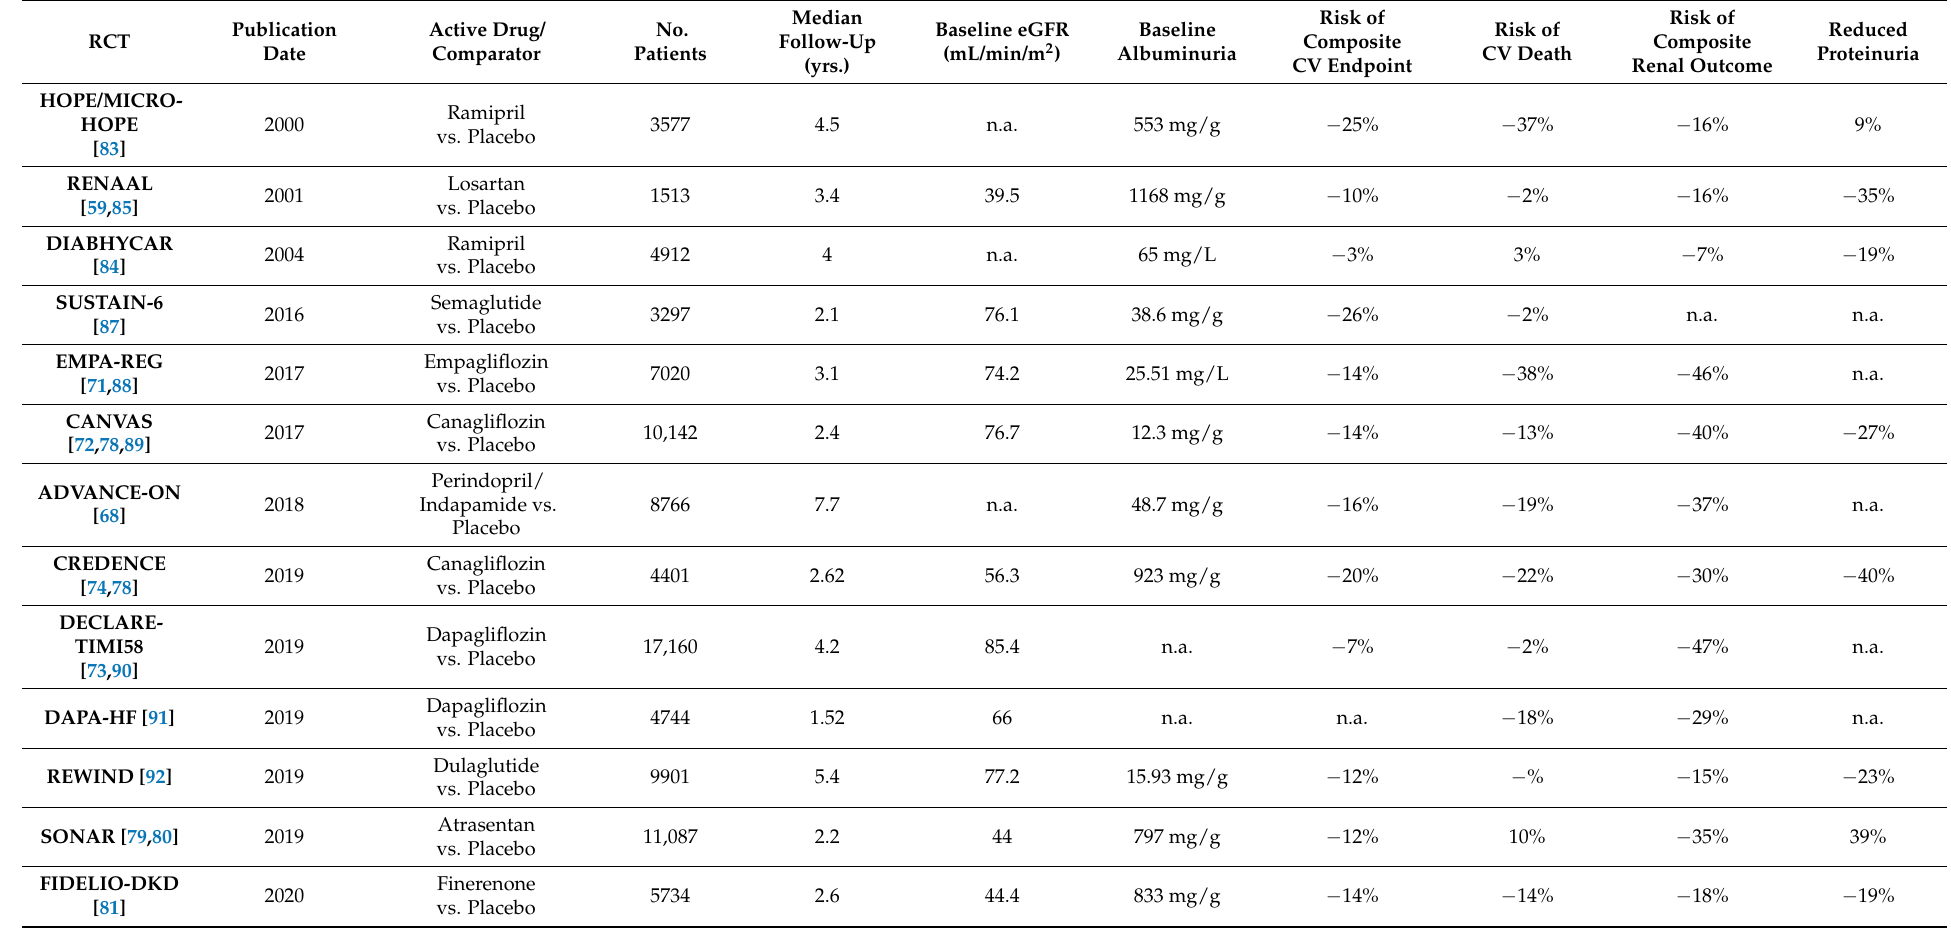
Table 1. Findings from the randomized clinical trials on cardiorenal outcome with antihypertensive and anti-hyperglycaemic